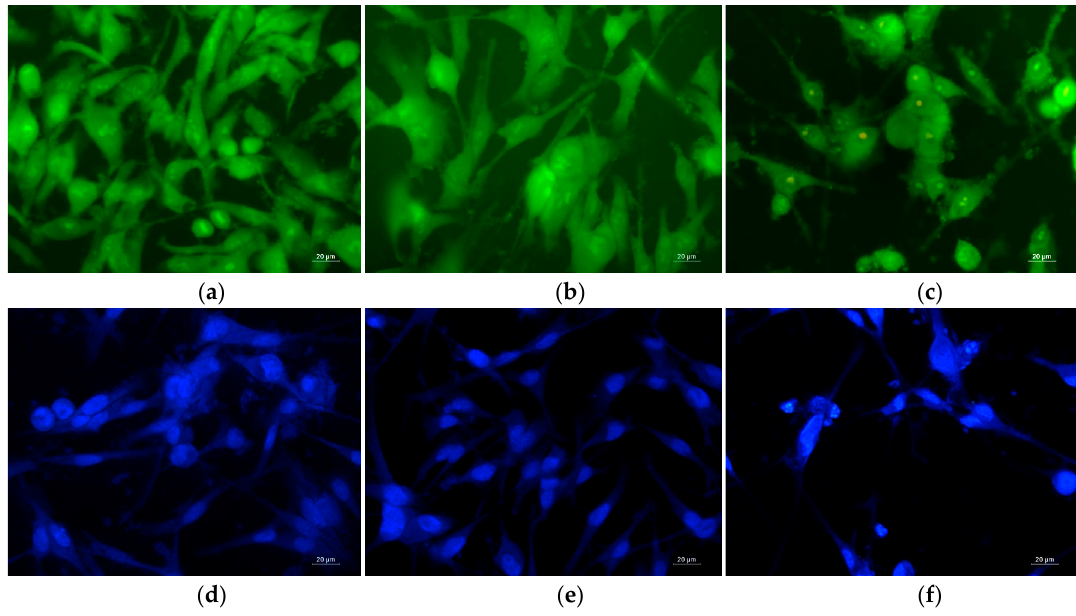
Figure 10. Fluorescence micrographs of AO and EtBr double-stained ( a–c ) and stained with DAPI ( d–f ) SH-4 skin melanoma cells incubated for 24 h (a and d) untreated cells; after incubation with: (b and e) CA/PEG mat, (c and f) CA/PEG/QUE mat; bar = 20 µm.